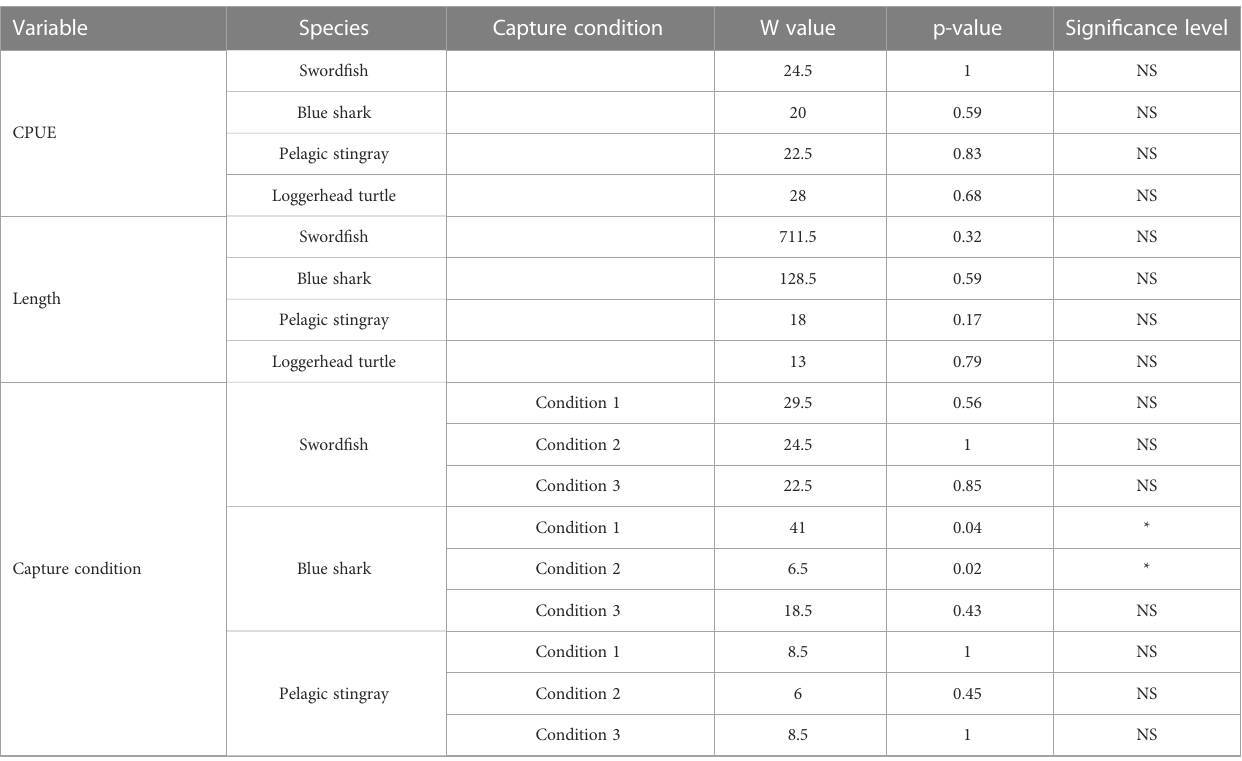
TABLE 4 Statistics (W value, p-value) and signi fi cance level according to the Wilcoxon ’ s tests carried out the different variables investigated (CPUE, length and capture condition) depending on the two hook types (C and J). Variable Species W value